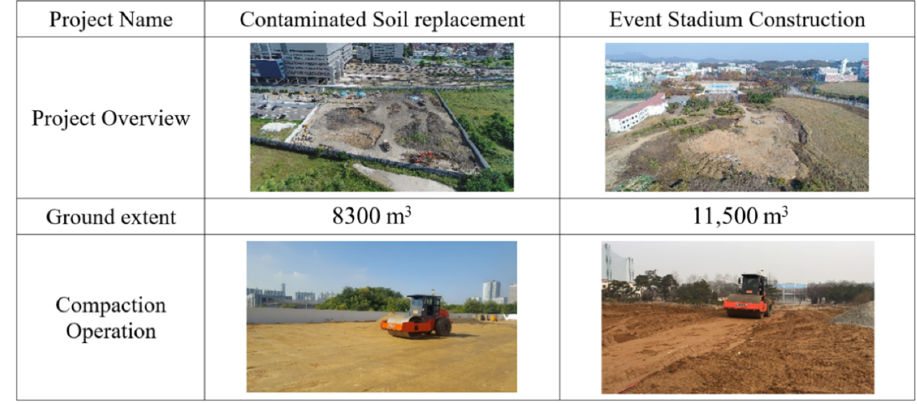
Figure 6. Research experiment environment.